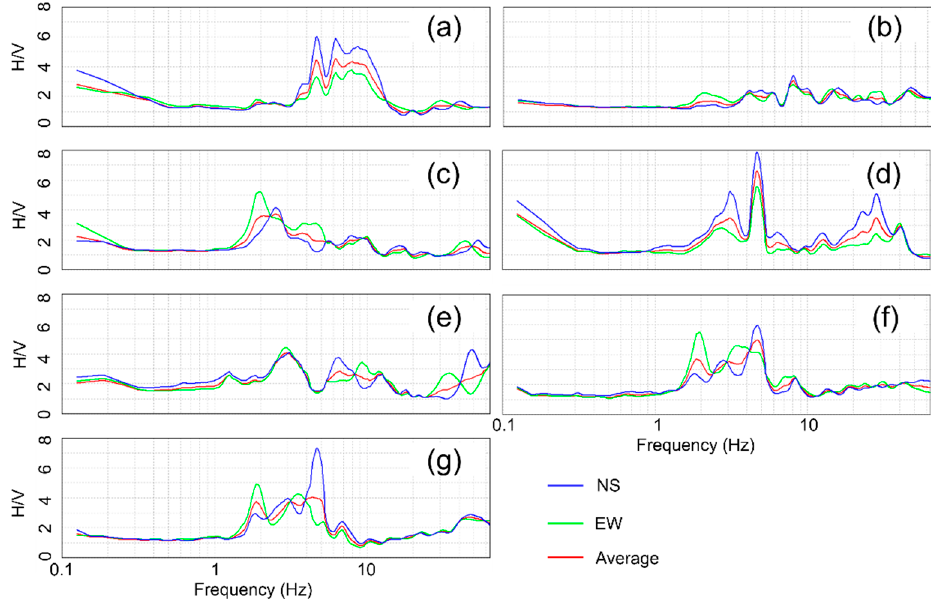
Figure 6. Results of microtremor-based HVSR tests performed in 2015; ( a ) HV1, ( b ) HV2, ( c ) HV3, ( d ) HV4, ( e ) HV5, ( f ) HV6, and ( g ) HV7.